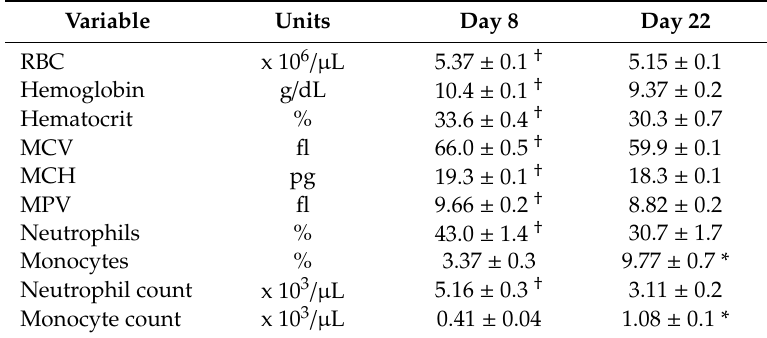
Table 5. Cell blood count variables that di ff ered significantly between day 8 and day 22 independent of 6 (cid:48) -SL sodium salt